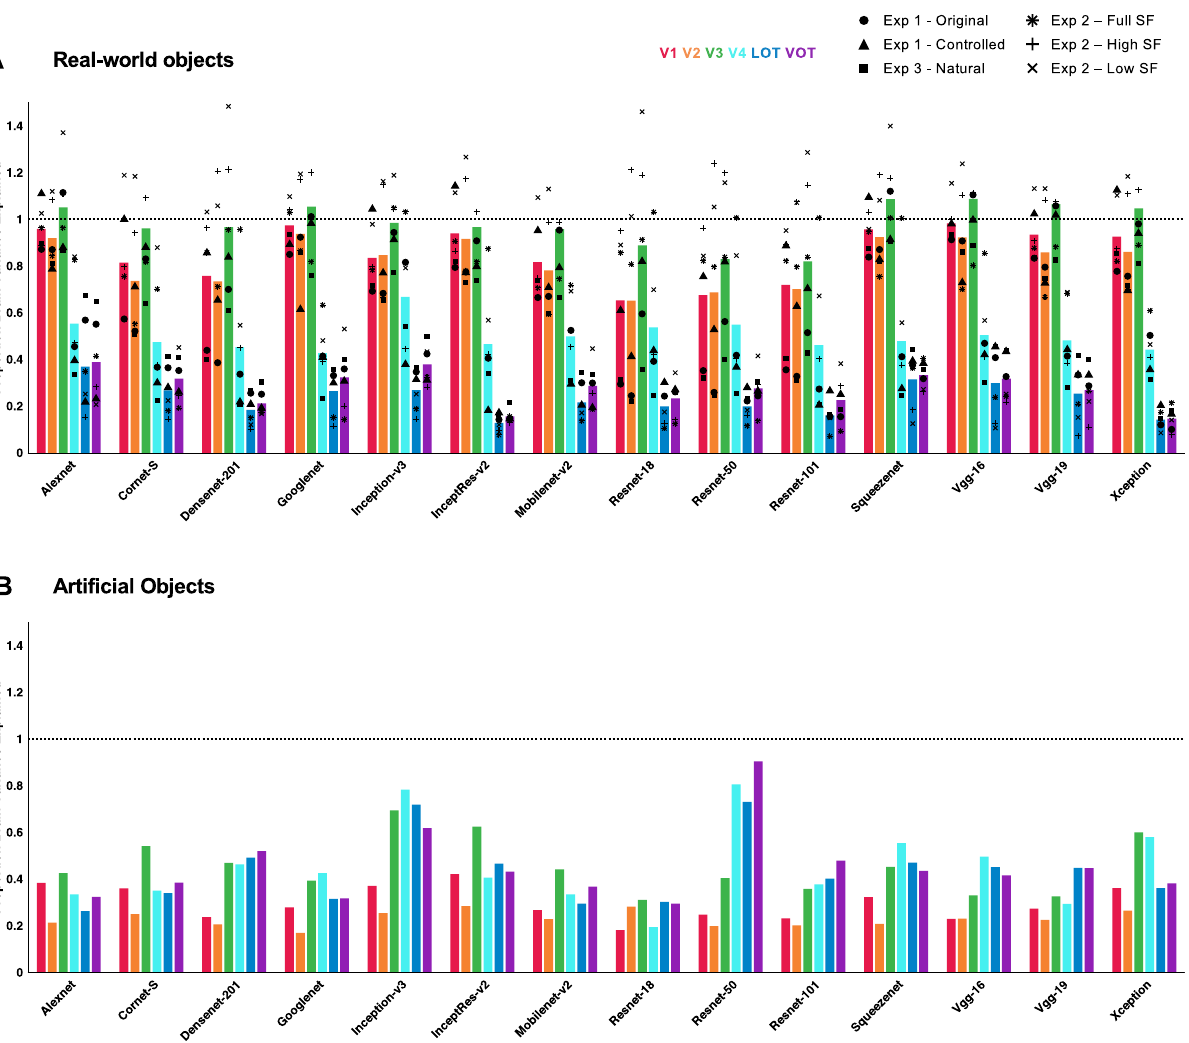
Fig. 7 Summary of results from all three experiments. A Summary of results from the six conditions across the three experiments that examined the processing of real-world object images (i.e., a summary of results from Figs. 3, 4, and 6). B Summary of results for the processing of arti fi cial objects (i.e., results from Fig. 6b). In A , each colored bar represents the averaged proportion of brain variance explained, with that from each condition marked by a black symbol. For real-world objects, a few CNNs (i.e., Alexnet, Googlenet, Squeezenet, and Vgg-16) were able to consistently capture brain RDM variance from lower human visual regions (i.e., V1 – V3). No CNN was able to do so for higher human visual regions (i.e., LOT and VOT). The CNNs capable of fully capturing lower-level brain RDM variance for real-world objects all failed to capture that of the arti fi cial objects from neither lower nor higher human visual regions. Source data are provided as a Source Data fi